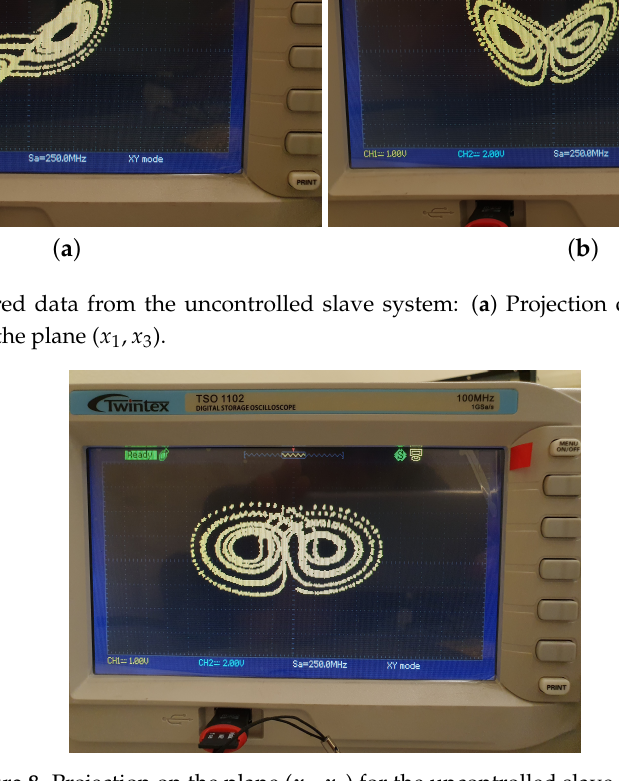
Figure 8. Projection on the plane ( x 1 , x 2 ) for the uncontrolled slave